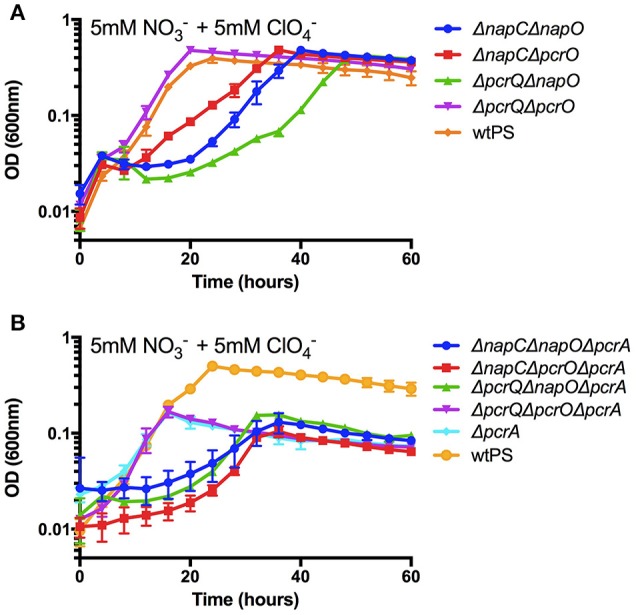
Growth of wtPS, ΔnapCΔnapO, ΔnapCΔpcrO, ΔpcrQΔnapO, and ΔpcrQΔpcrO
(A), and ΔpcrA, ΔpcrAΔnapCΔnapO, ΔpcrΔnapCΔpcrO, ΔpcrAΔpcrQΔnapO, and ΔpcrAΔpcrQΔpcrO
(B) on LMM medium with 5 mM nitrate and 5 mM perchlorate. Error bars represent standard deviations of biological triplicate samples.